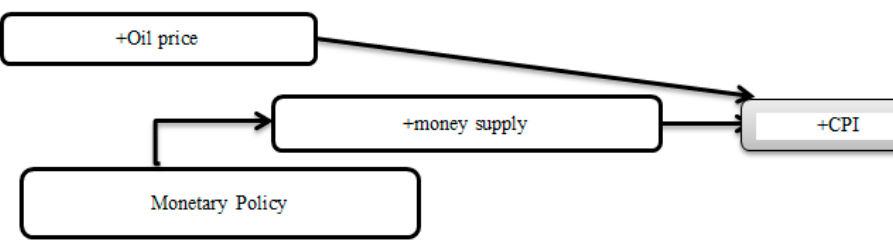
Figure 3. The oil price transmission channel into the consumer price index (CPI).